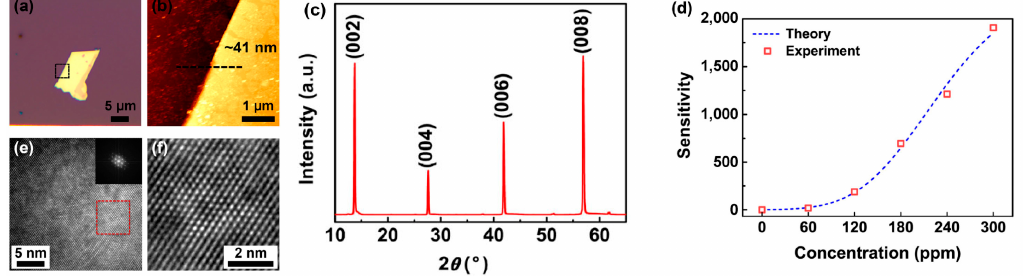
Figure 12. ( a ) Optical image; ( b ) Atomic Force Microscopy (AFM) image; ( c ) XRD pattern; ( e ) Fast Fourier Transform (FFT); and ( f ) inverse FFT image of CVD-grown multilayer MoSe 2 flake. The thickness of the MoSe 2 flake is about 41 nm. ( d ) Sensitivity vs. NO 2 concentration, where the dashed blue line is based on a model, and the red square symbols represent the data from the experiments. Reprinted with permission from [89]. Copyright 2017 Springer-Verlag Berlin Heidelberg.